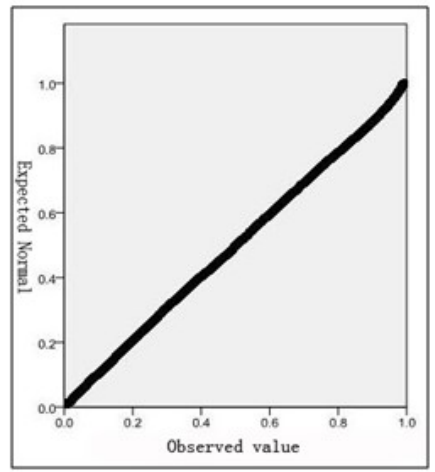
In Figure 1, X axis represents the value of correlation coefficients. The left side in vertical axis represents the frequency of correlation coefficients. The right side represents the probability density of correlation coefficients. As we can see, the probability density distribution curve approximately obeys the normal distribution.